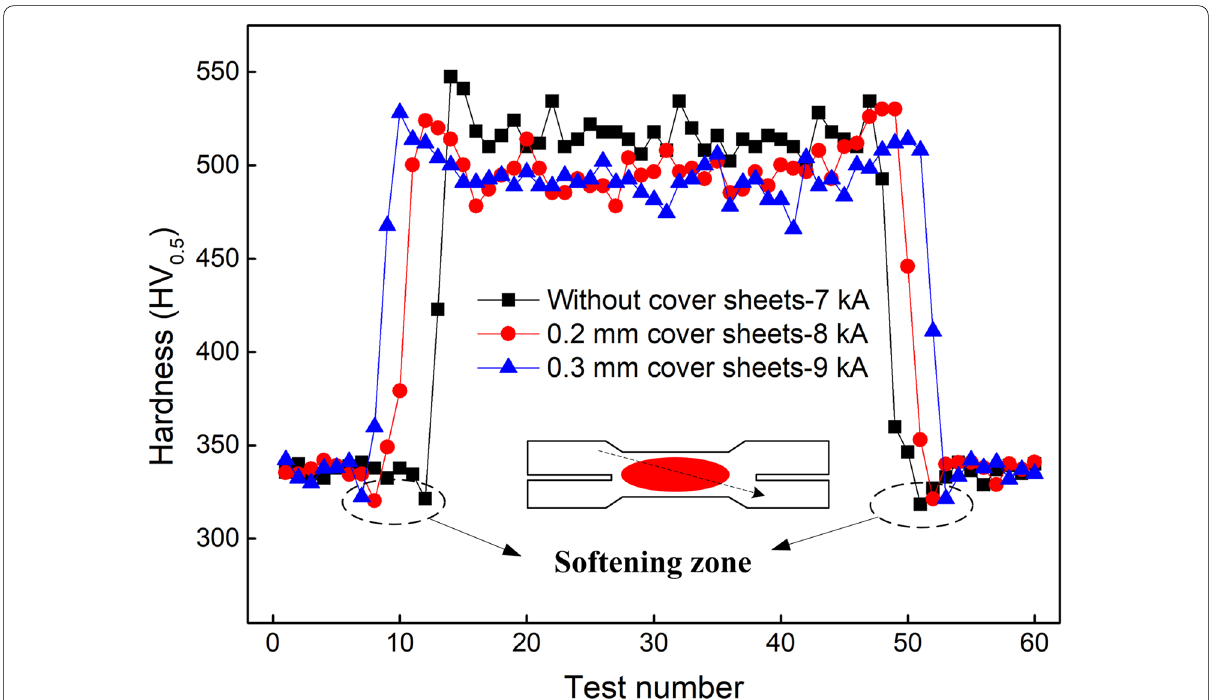
Figure 5 Hardness distributions of joints with and without cover sheets under critical welding